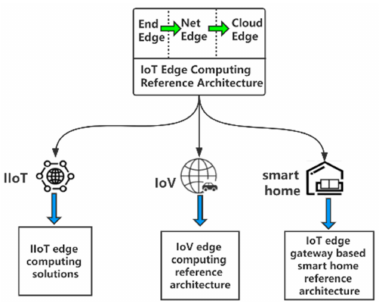
Figure 3. Application scenarios for the EC-IoT reference